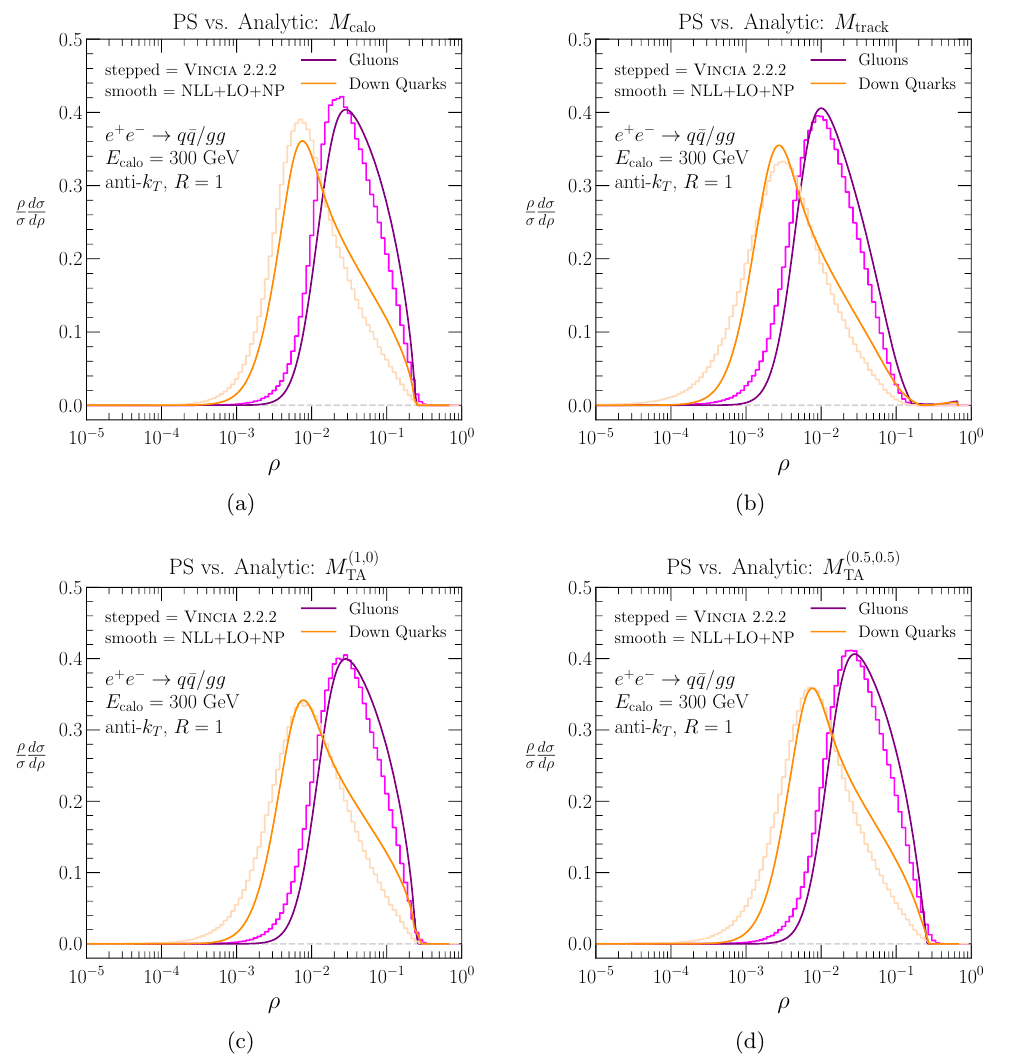
Figure 12 . GTAM distributions computed from Vincia (stepped histograms) and NLL+LO with non-perturbative corrections (smooth curves). Shown are (a) calorimeter jet mass, (b) track mass, (c) track-assisted mass, and (d) GTAM with (cid:20) = 0 : 5 and (cid:21) = 0 : 5. The high-side discrepancy between our analytic calculation and Vincia is already present in the log- R matching procedure, even before convolution with the non-perturbative shape